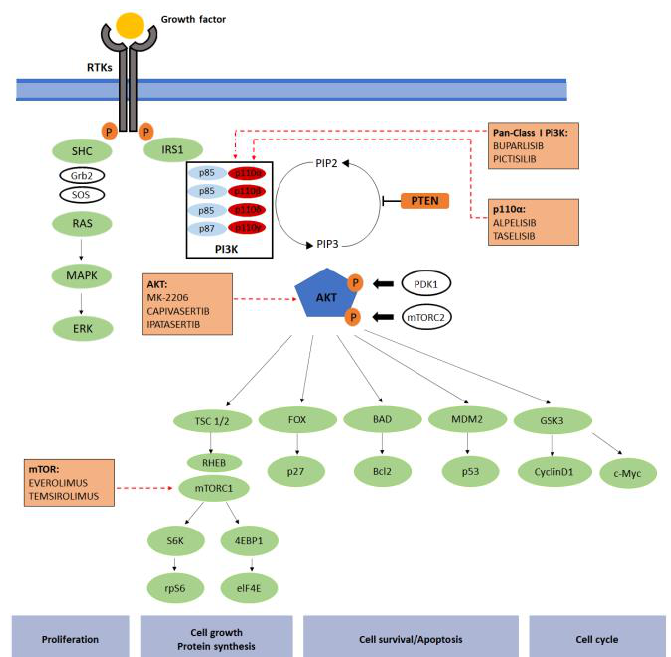
Figure 1. PI3K signaling pathway. The PI3K signaling pathway has a role in mechanisms such as cell growth, survival and metabolism. Following growth factor stimulation and subsequent activation of RTKs, class IA proteins are recruited to the membrane by direct interaction with p85 subunit, with the activated receptors or by interaction with adaptor proteins associated with the receptors. The p110 β -containing enzymes might be activated by GPCRs converting PIP2 to PIP3 and providing docking sites for PDK1 and AKT. In particular, PDK1 phosphorylation and AKT activation regulate a downstream signaling event where PTEN is one of the most important final targets. The figure underlines where the multi-, pan- or isoform-specific inhibitors